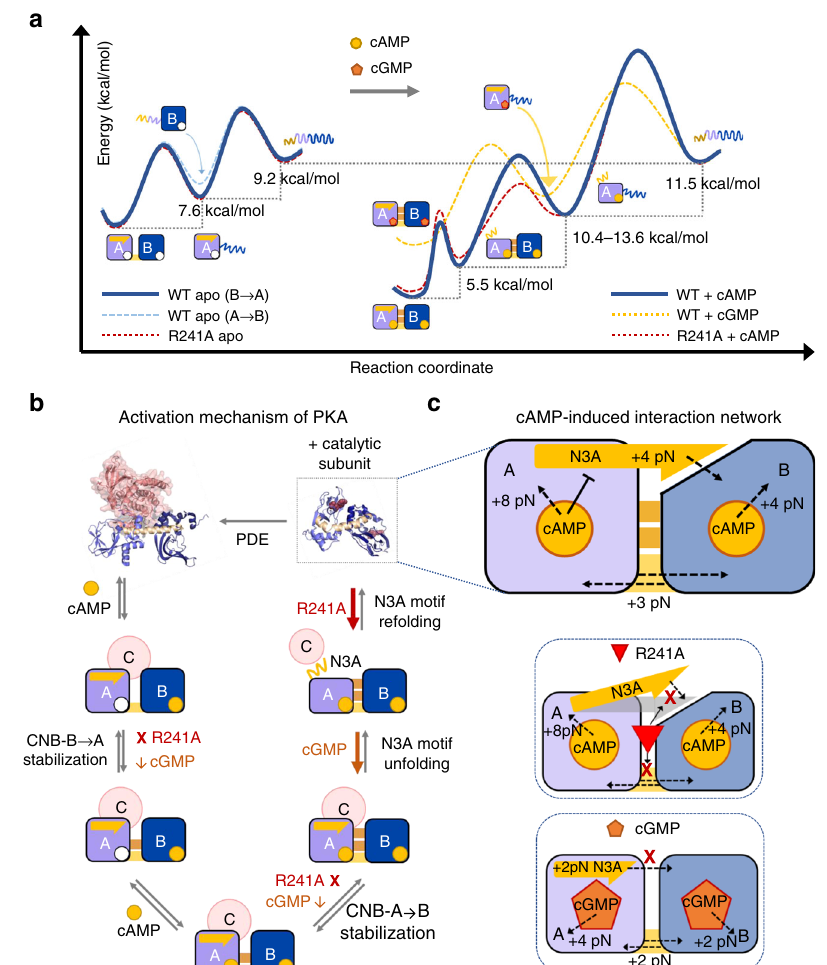
Fig. 8 Activation of PKA through selective stabilization of CNB domains. a Unfolding energy landscape of the regulatory subunit in the apo state (left) and bound to cyclic nucleotide (right). The unfolding pathway in the apo state follows a CNB-B-to-CNB-A order in 80% of events (solid blue line). In the other 20%, the apo CNB-A domain unfolds fi rst (dashed light blue line). The apo R241A mutant (dashed red line) has an indistinguishable energy landscape compared with apo wild type. In the presence of cAMP, the unfolding order in wild type is as follows: the N3A motif, the CNB-B domain, and the CNB-A domain. The cAMP-bound R241A mutant follows a similar unfolding order, but the CNB-B domain unfolds with a lower energy barrier and has lower stability due to the lack of stabilizing inter-domain interactions. The cGMP-bound wild type follows an unfolding pathway that is quantitatively and qualitatively different to that of the cAMP state (see main text for details). The height of the energy barriers re fl ects the folded and unfolded-state lifetimes of the CNB domains (Supplementary Tables 2 – 5). The energy landscapes have been normalized to the unfolded state. b Activation mechanism of PKA showing intermediate states and their cAMP-initiated interactions. Steps and interactions disrupted by R241A and cGMP are shown as “ X ” (complete disruption) or “ down-arrow ” (decreased in magnitude). c Top: interaction network initiated by cAMP binding involves stabilizing (dashed black arrows) and destabilizing ( fl at black arrow) coupling (top). Effect of R241A (middle) and cGMP (bottom) on interaction